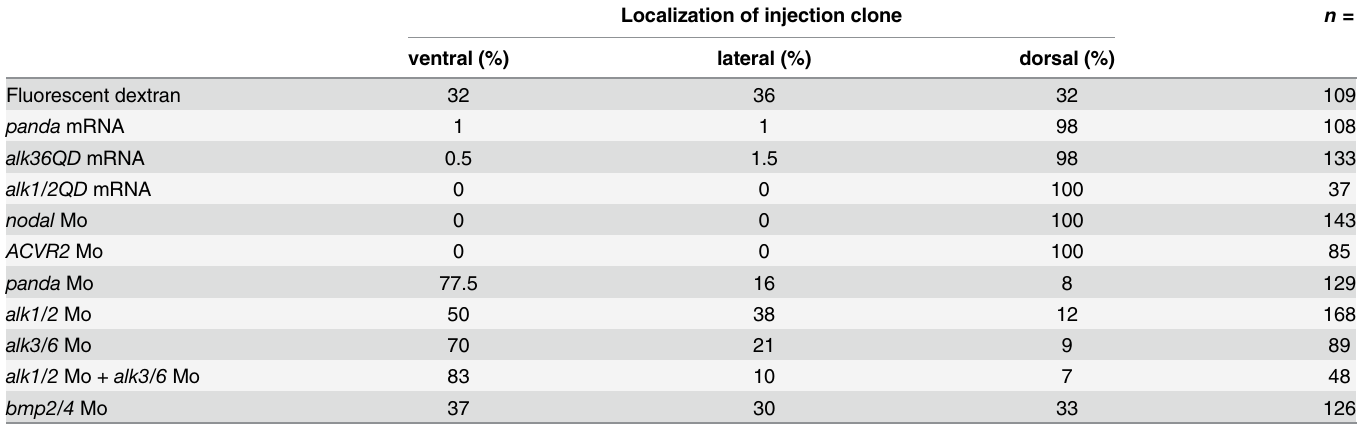
Table 1. Ability of various components of the Nodal or BMP pathways to orient the D/V axis following misexpression into one blastomere at the two-cell stage. Localization of injection clone n = ventral (%) lateral (%) dorsal (%) Fluorescent dextran 32 36 32 109 0.5